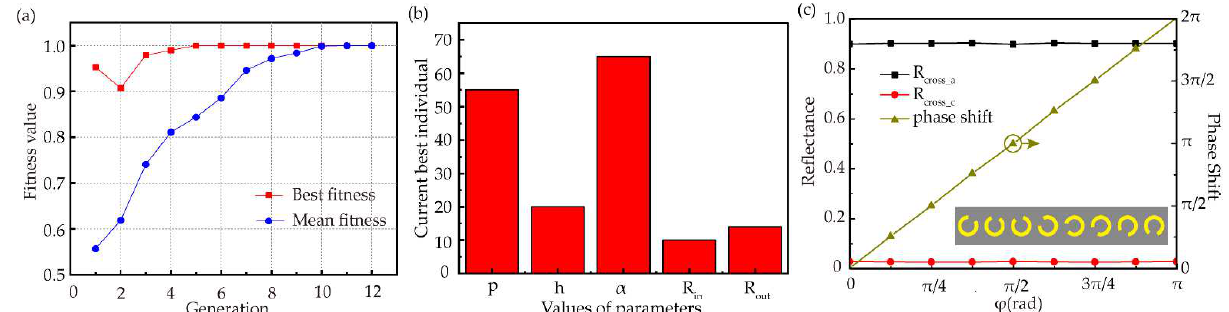
Figure 3. ( a ) The variation of fitness value with generation in the optimization. ( b ) The values of the parameters for the best optimized individual. ( c ) Simulated cross-polarization reflectance and phase shift as a function of rotation angle ϕ in amorphous state and cross-polarization reflectance in crystalline state. The deep yellow line corresponds to the vertical axis on the right, and the unit with different rotation angles in the inset represent different phase shifts.